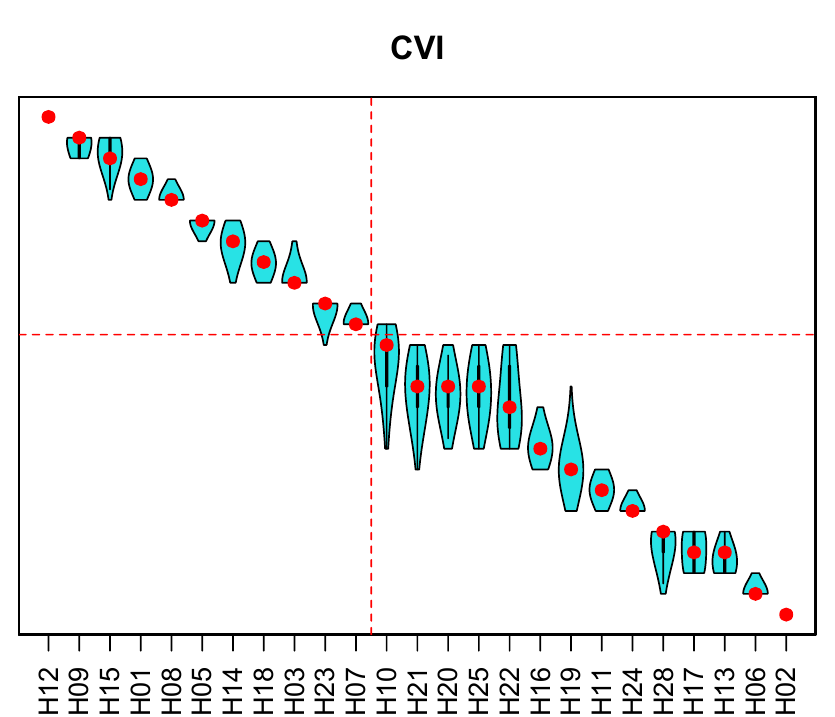
Figure 7. Results of the sensitivity analysis for the ranking of hospitals with respect to the cerebrovas- cular insult. Violin plots show distribution of ranks from the Monte Carlo simulation. Dashed red lines indicate the 40% best-performing hospitals. The same numbering of hospitals is used as in Figure 6.